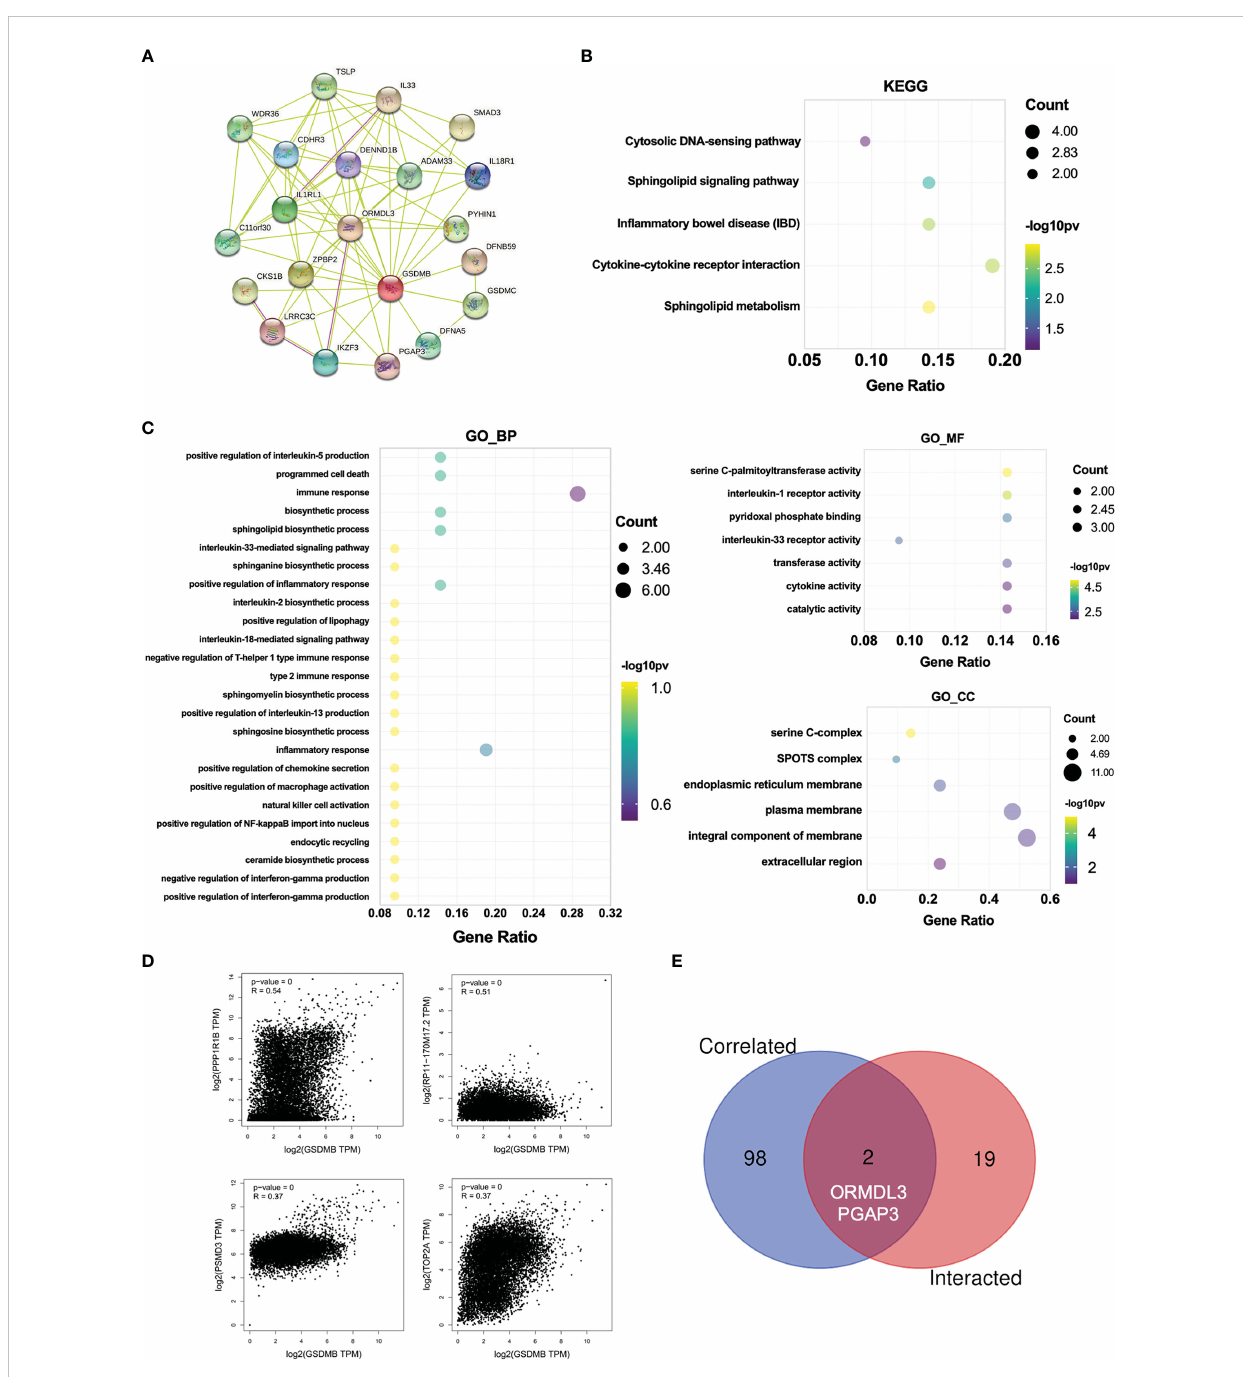
FIGURE 6 Enrichment analysis for GSDMB-related genes. (A) Protein – protein interaction network between all available experimentally determined GSDMB- binding proteins using the STRING tool. (B) The KEGG pathway and GO enrichment analyses (C) were performed on GSDMB-binding genes. (D) The correlation between GSDMB and selected binding genes, such as PPP1R1B, RP11-170M17.2, PSMD3, and TOP2A. (E) The Venn diagram shows two types of crossover genes, including ORMDL3 and PGAP3. GSDMB, gasdermin B; KEGG, Kyoto Encyclopedia of Genes and Genomes; GO, Gene